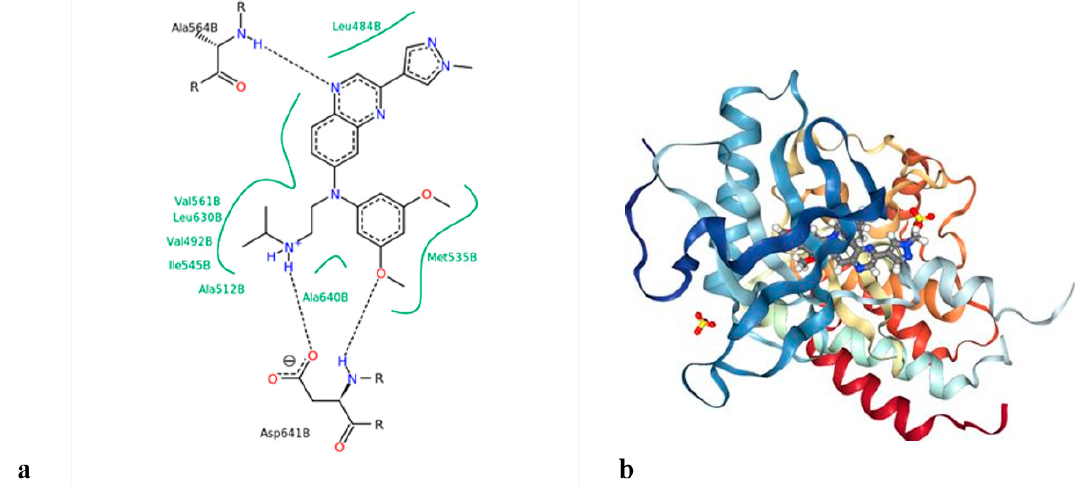
Figure 9. ( a ) Structure of JNJ-42756493 ( b ) Interaction of JNJ-42756493 with FGFR1 (PDB code